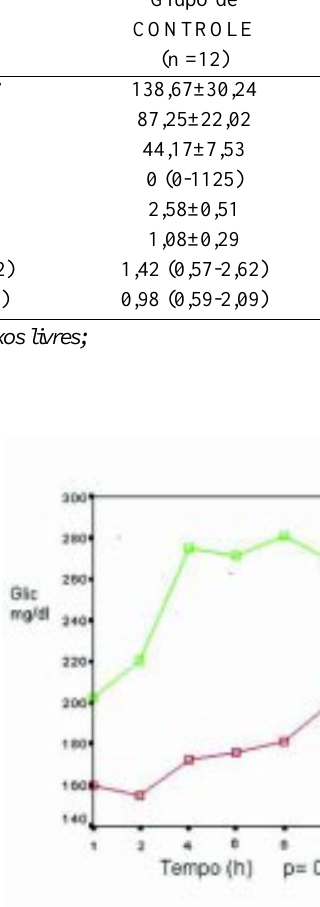
Fig. 1 - Médias do Índice Cardíaco - Gráfico ilustrando o comportamento do Índice Cardíaco nos grupos GIK e de controle